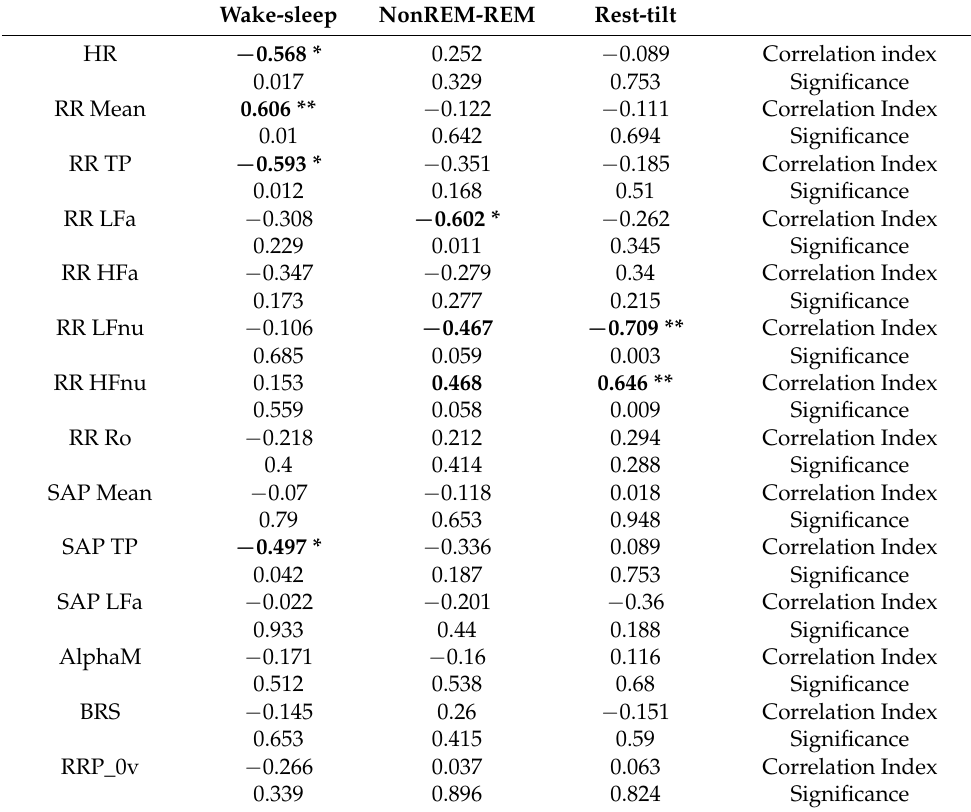
Table 4. Spearman correlation between changes in autonomic indices during spontaneous inhibitory (wake to sleep) or spontaneous excitatory (non-REM to REM sleep) or physiologically induced events (rest to tilt) and position of Spinal Cord